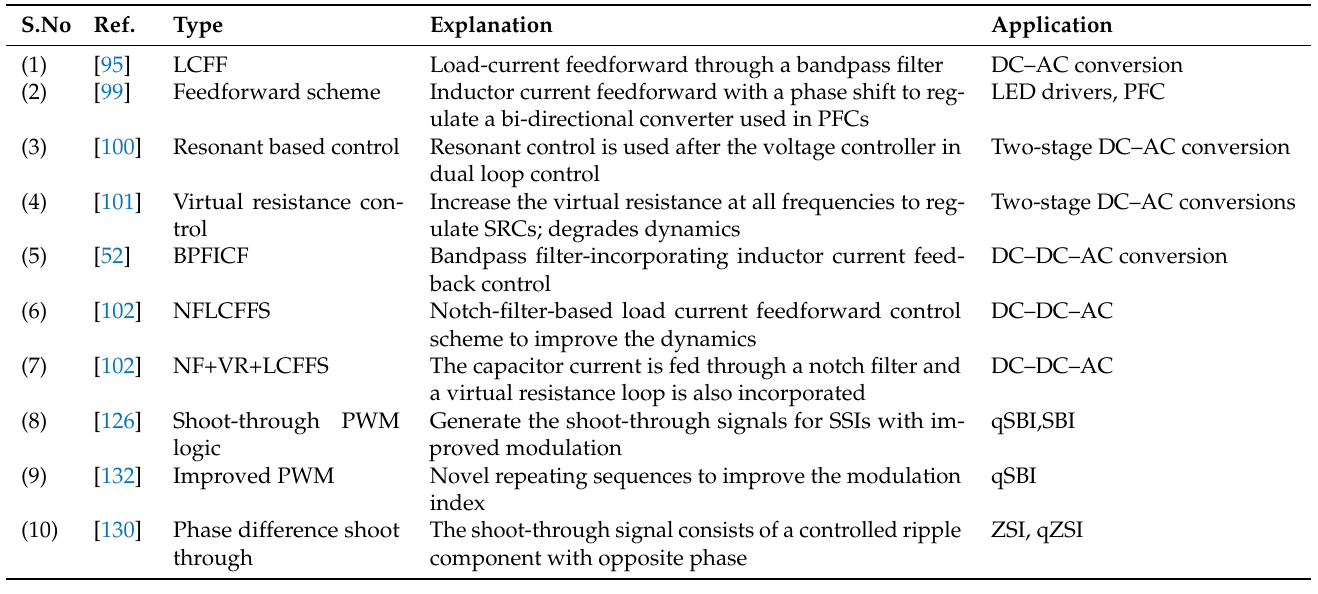
Table 2. Summary of virtual control methodologies.